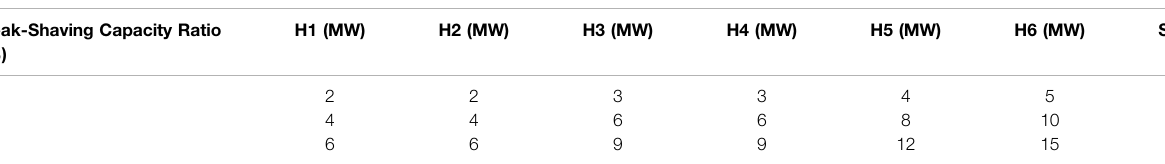
TABLE 3 | Different scenarios based on S3.